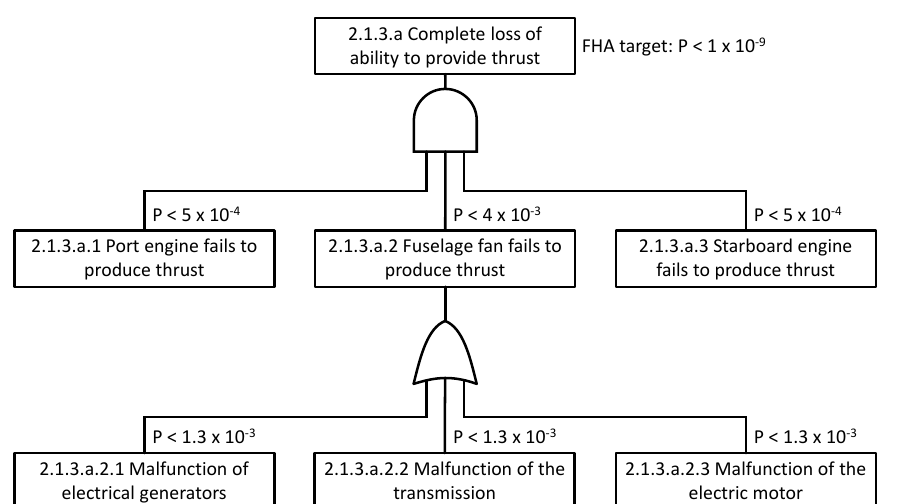
Figure 30. Example FTA for complete loss of ability to provide thrust for the CENTRELINE PFC aircraft.